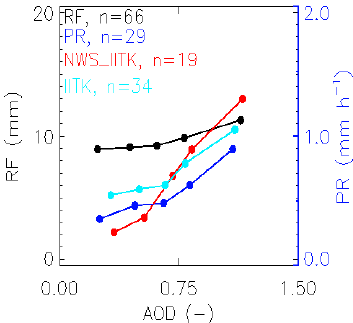
Figure 12. Associations of rainfall with collocated AERONET- AOD measurements (within ± 4h of the start or end of rainfall event) over IITK. The cyan line illustrates the scenario with the inclusion of the wet-scavenging effect (IITK), and the red line il- lustrates the scenario with no wet-scavenging effect (NWS_IITK). The association between daily rainfall and precipitation rate with MODIS-AOD over the IITK grid is also shown by black and blue lines, respectively. In each case, all the rainfall–AOD samples were sorted as a function of corresponding AOD values into five bins of 20 percentiles each. Each scatter point is the average of each bin and has n number of data